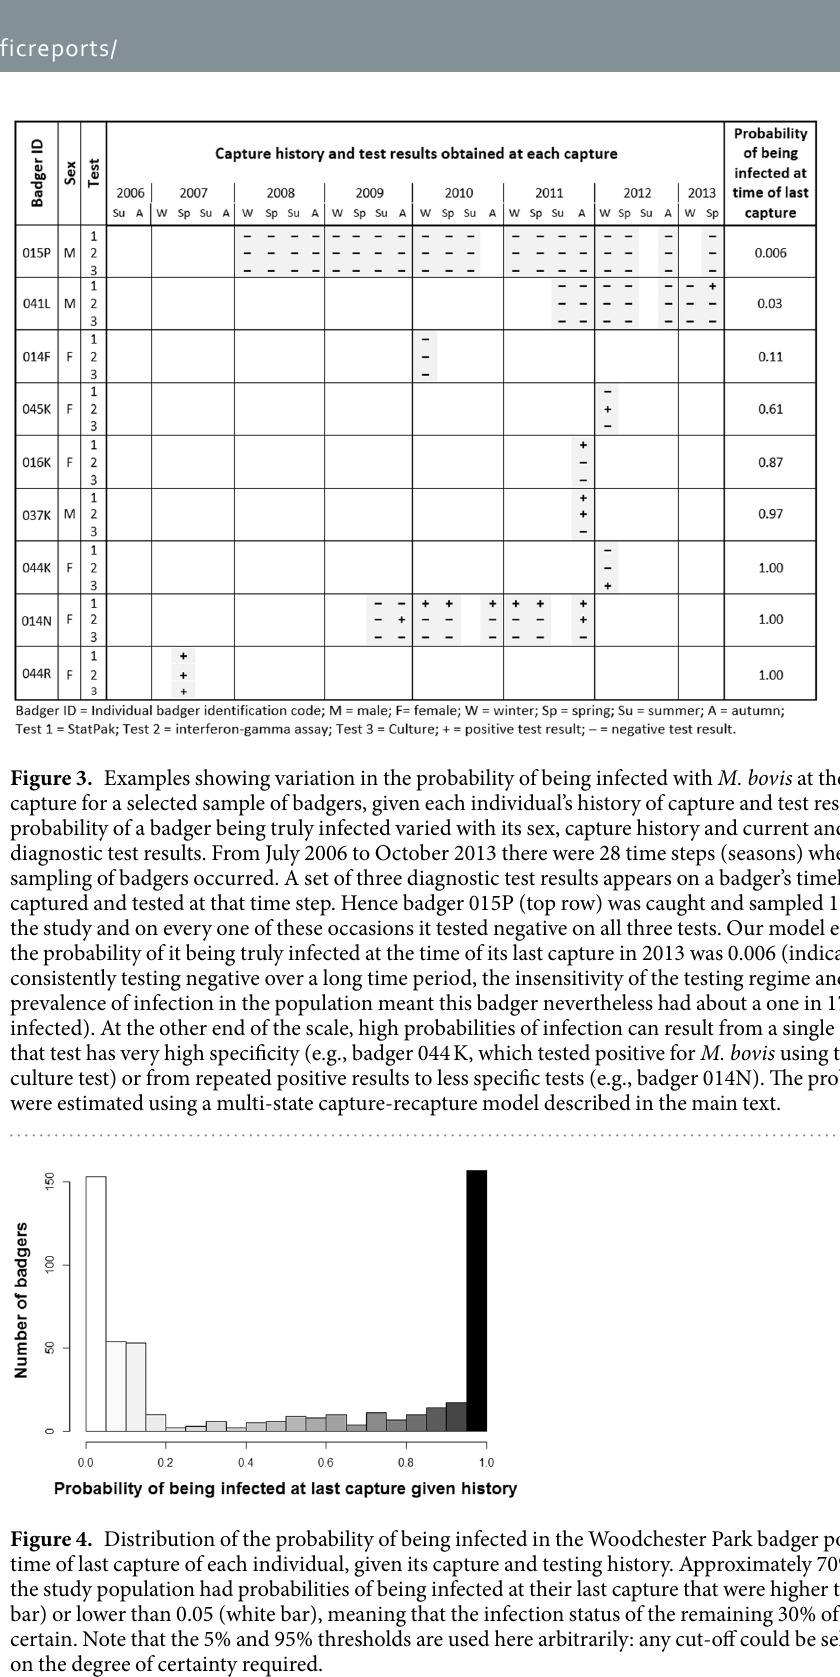
interventions that employed this approach. In the case of cage trapping to cull, it would mean that uninfected animals were preferentially removed, which would reduce the effectiveness of the operation. This phenomenon could potentially have contributed to the increase in M. bovis prevalence observed over sequential culls during